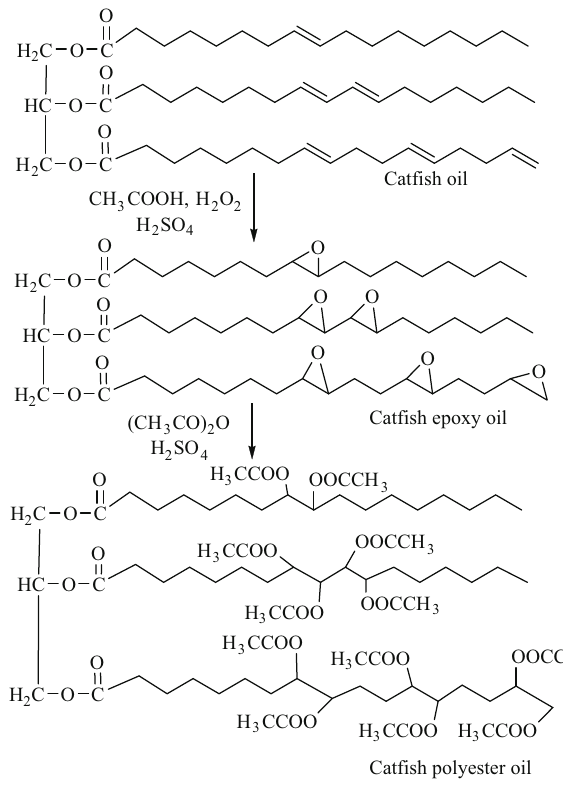
Figure 2: The synthesis reaction scheme of CES from cat fi sh